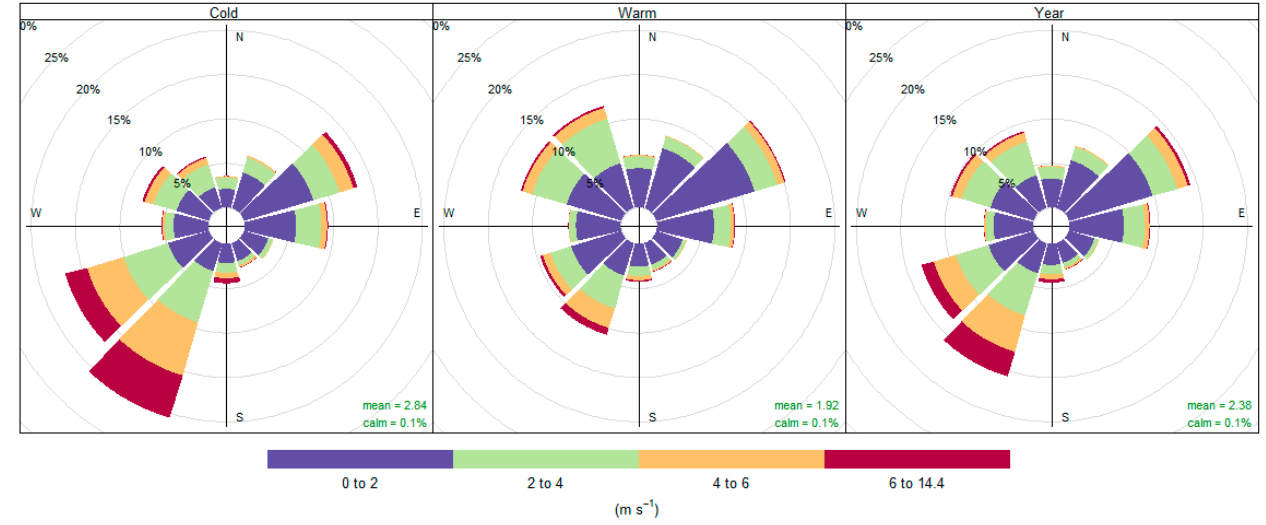
Figure 3. Average frequency of counts by wind direction, 2011–2020, V ěřň ovice.